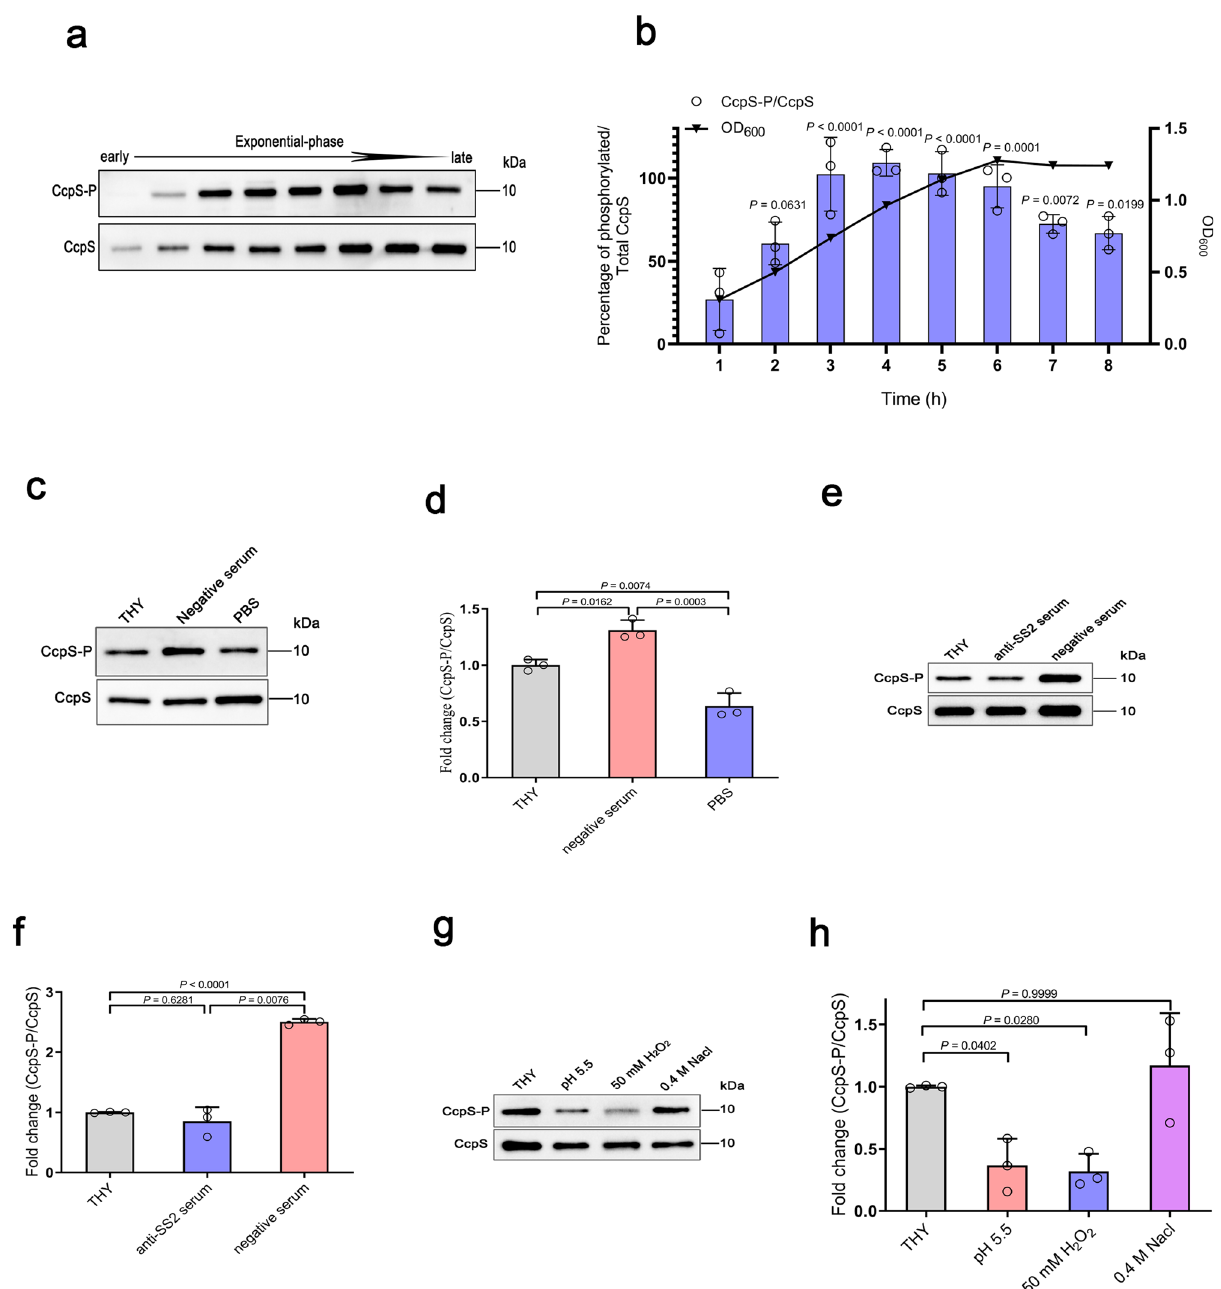
Fig.2|CcpSphosphorylationparticipatesinvariousstressresponse. IPanalysis of S. suis CcpS phosphorylation using anti-CcpS beads from whole-cell lysates of cellswithnormalgrowthorvarioustreatments.Westernblotofimmunoprecipitate analysed on an SDS gel using anti-CcpS antibodies for CcpS and anti- phosphothreonine antibody for CcpS-P. a Cells from different growth stages, cells were harvested at the indicated time from early to late exponential-phase. c Exponentially growing cells were treated with starvation in PBS or nutrient medium (THY supplemented with negative serum for S. suis at a ratio of 1:1) for 20min. e Exponentially growing cells were treated with THY supplemented with